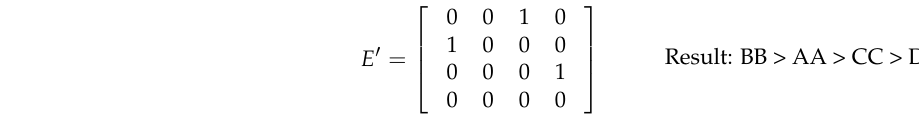
Table 9. Modified compound advantage matrix E (cid:48)